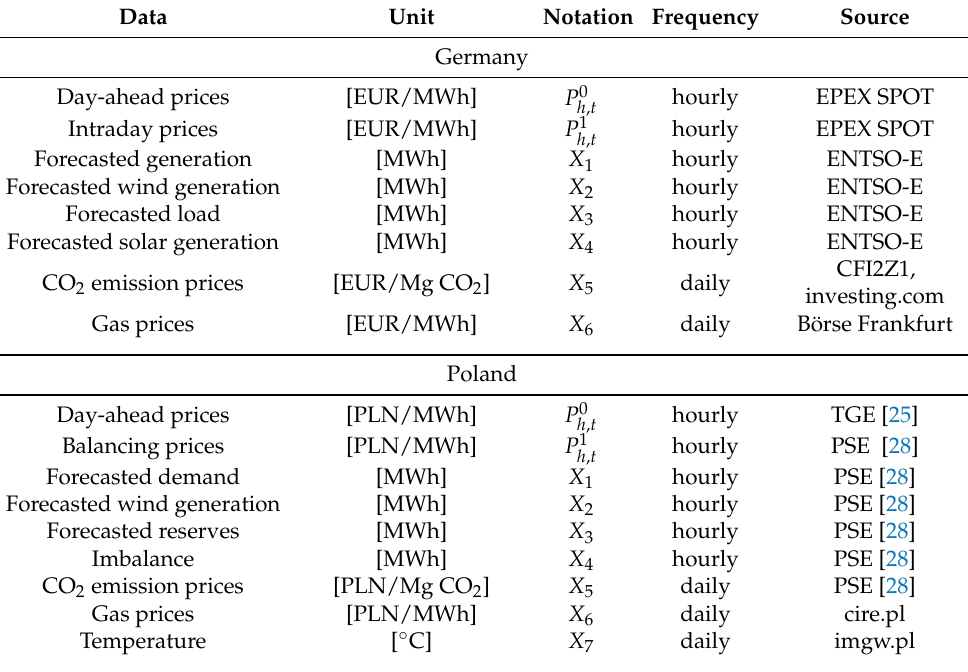
Table 1. A list of variables together with their unit, notation, frequency and